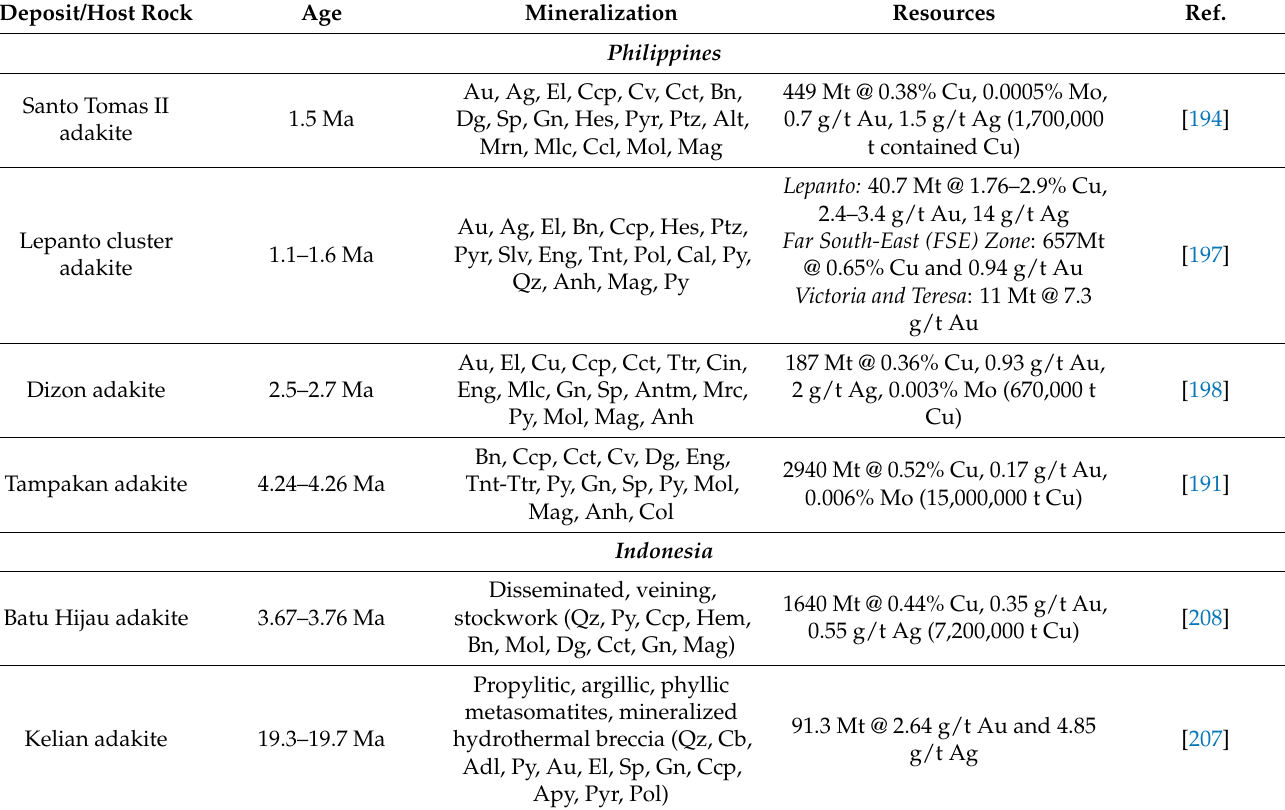
Table 8. Main characteristics of selected Cu–Au deposits associated with adakites and high-Nb basalts in the Philippines, Indonesia and Papua New